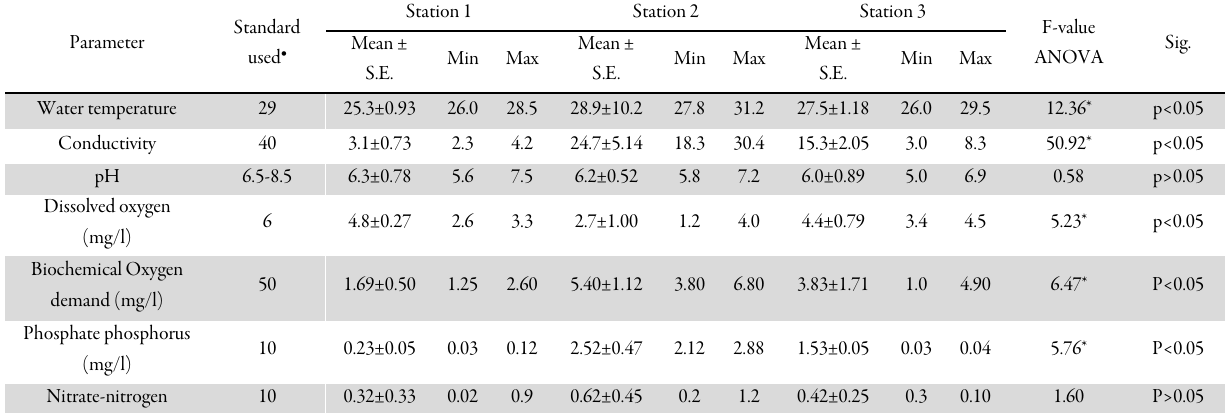
Table 1. Summary of physicochemical properties of River Idemili